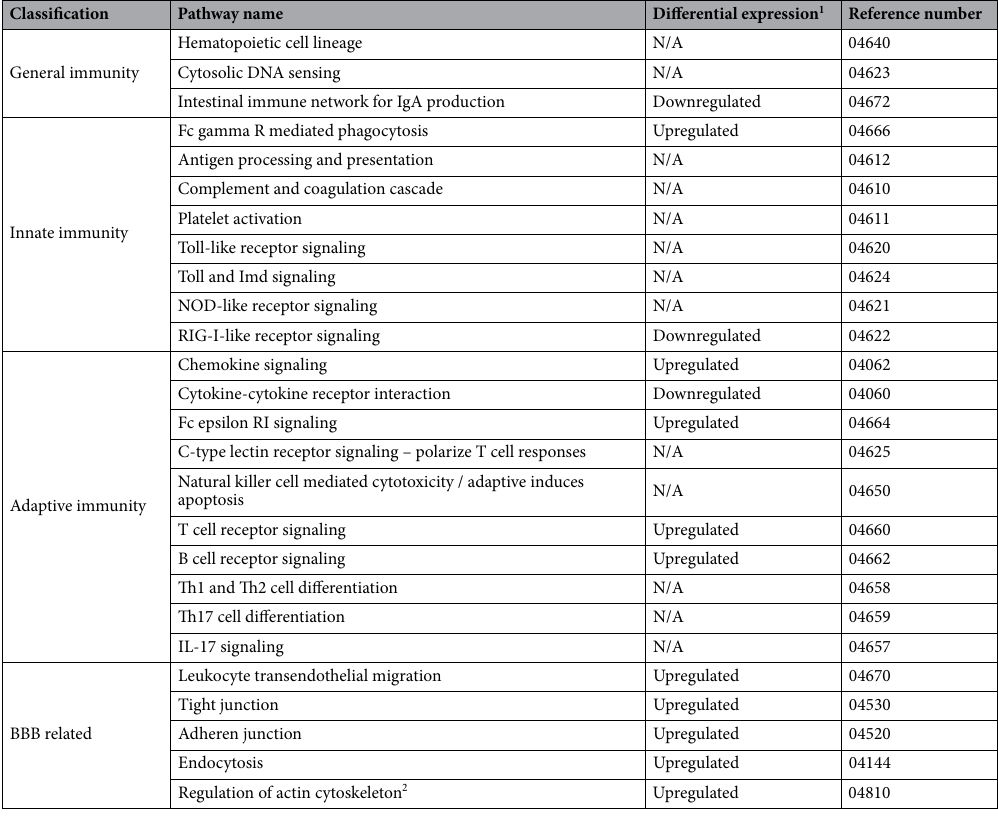
Table 1. List of immune related KEGG pathways considered in this study. 1 Differential regulation as reported by Haque et al. 12 . 2 Subpathway of the Leukocyte transendothelial migration pathway.